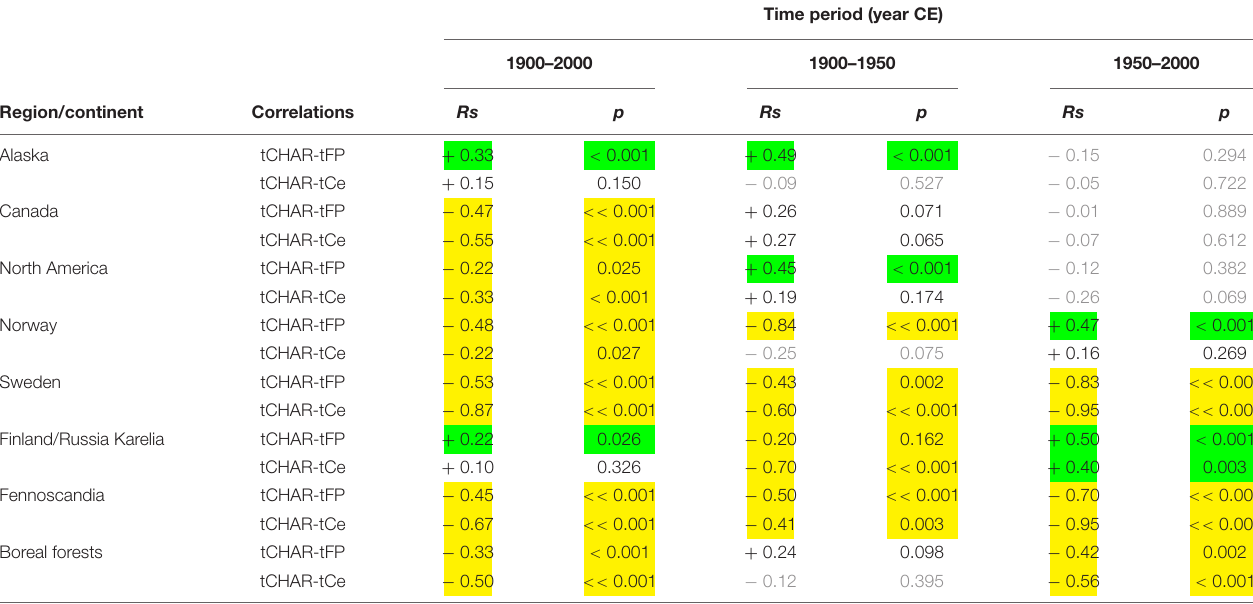
TABLE 3 | Results of Spearman rank correlation analyses ( Rs ) and significance level ( p